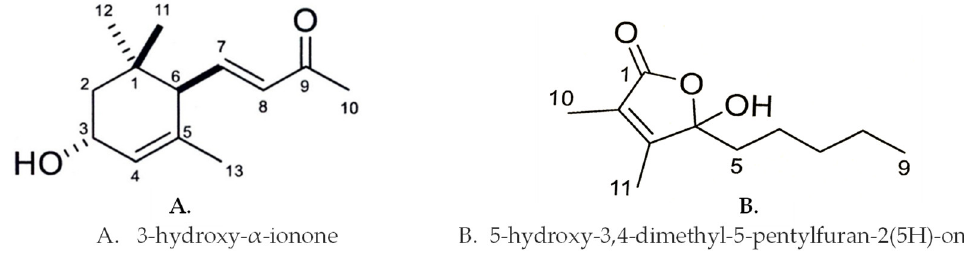
Figure 4. Structures of ( A ) 3-hydroxy-α-ionone and ( B ) 5-hydroxy-3,4-dimethyl-5-pentylfuran- 2(5H)-one.